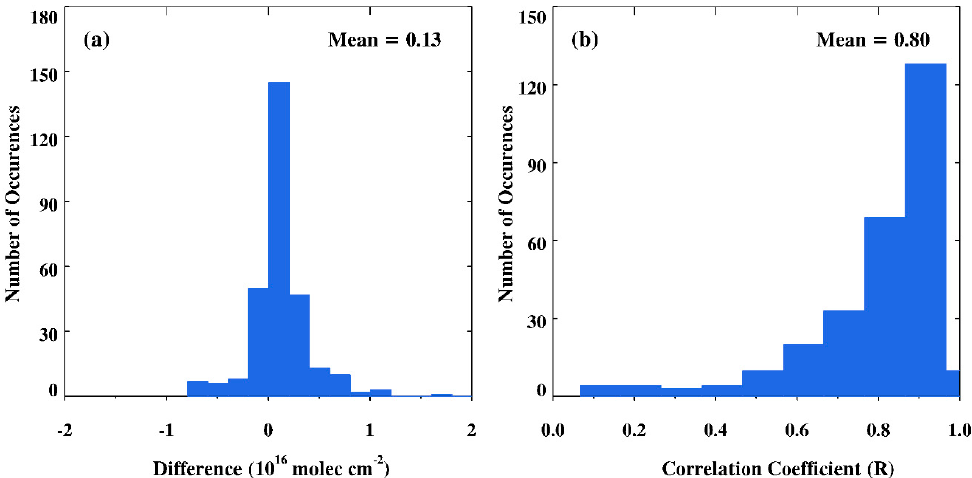
Figure 6. Histograms of the ( a ) absolute difference and ( b ) correlation coefficient between daily OMI and TROPOMI75 data over the Jing ‐ Jin ‐ Ji region.